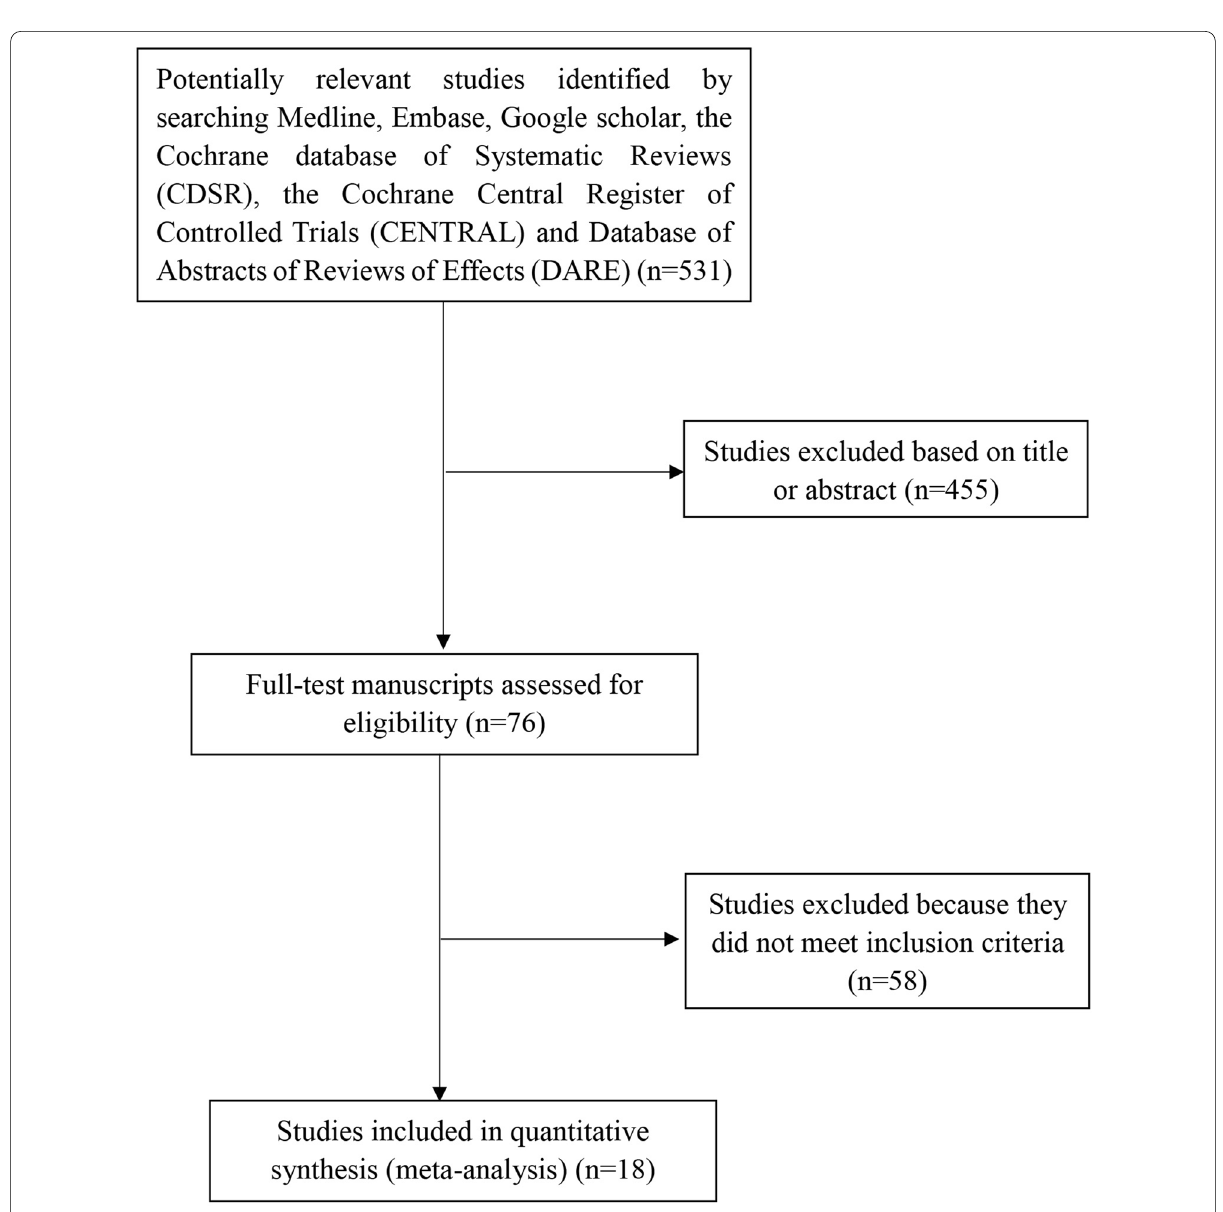
Fig. 1 Flowchart of studies for